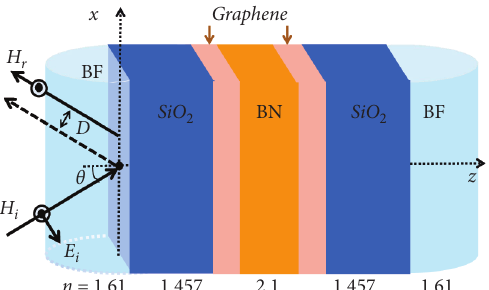
Figure 1: Schematic diagram of the GH shift of total reflected beams from a planar multilayer